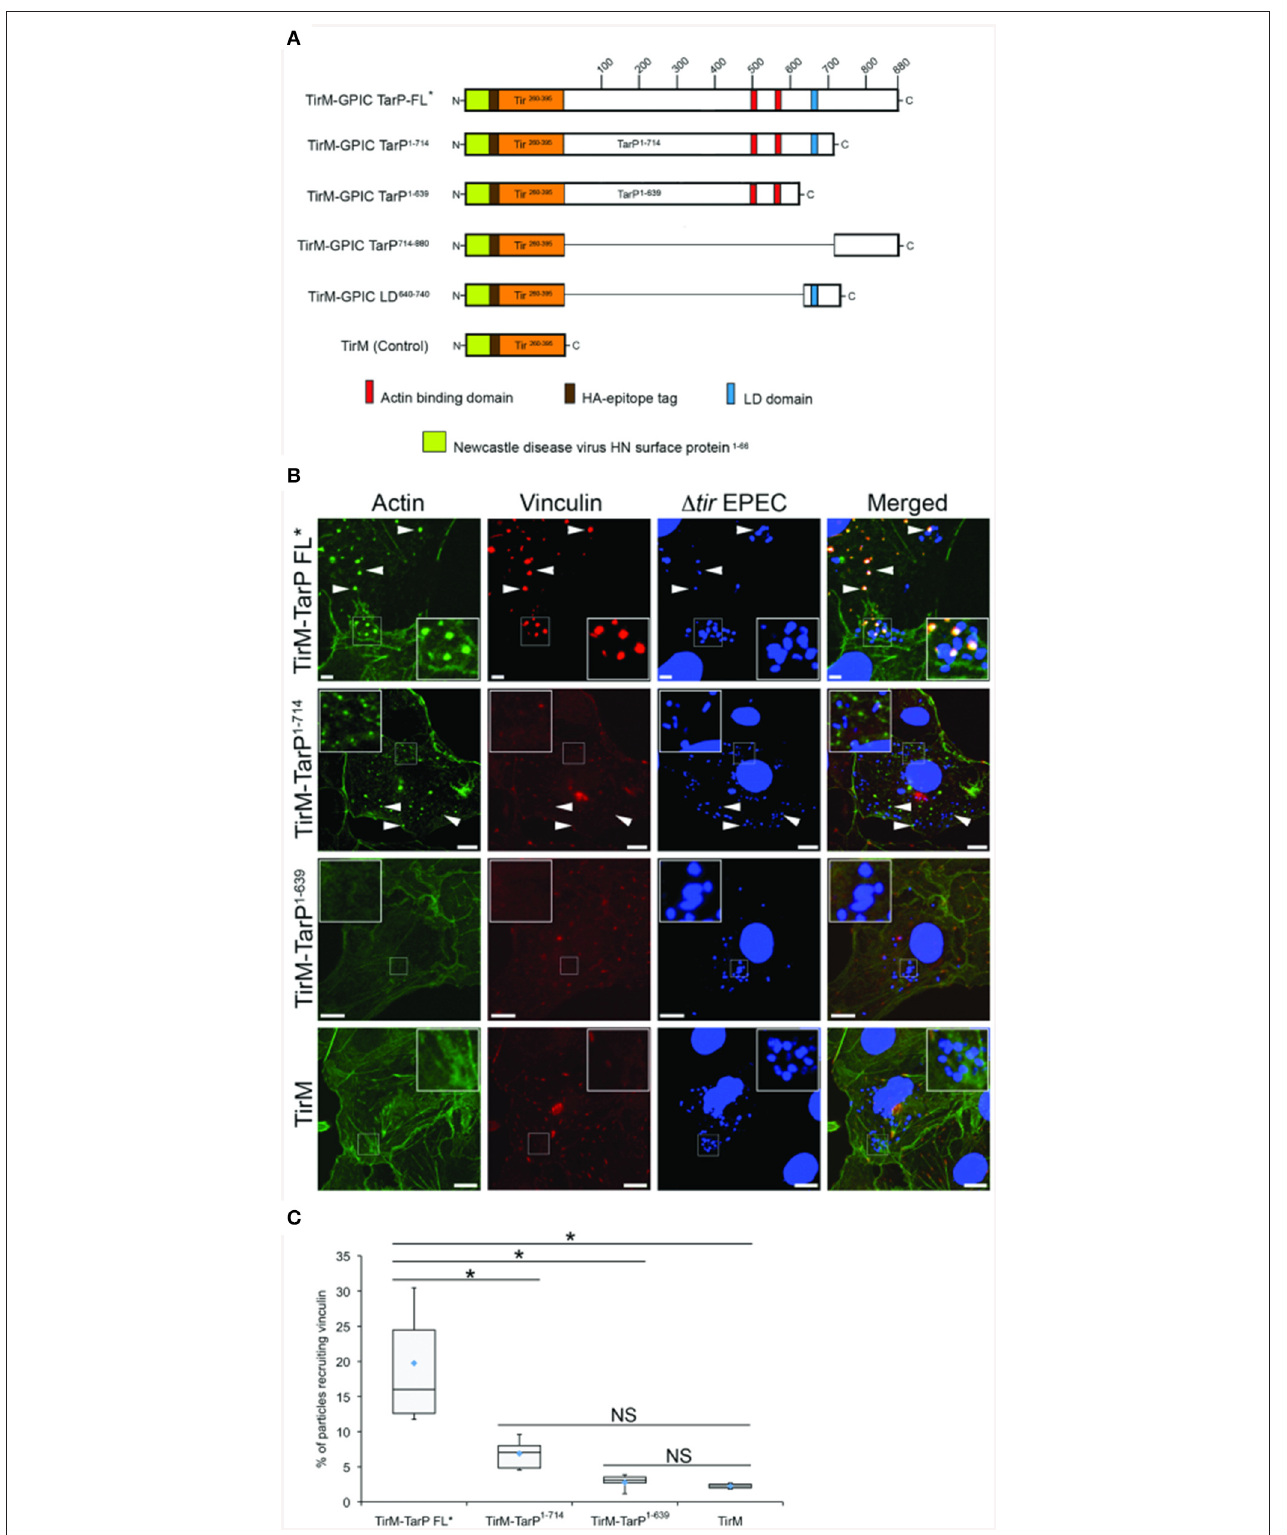
FIGURE 3 | C. caviae TarP-mediated vinculin recruitment requires the vinculin binding domain. (A) Schematic indicating the locations of the membrane targeting sequence (yellow box), Ha-tag (brown box), TirM (amino acids 260–395; orange box), actin binding domains (red box), and the LD domains (blue box).